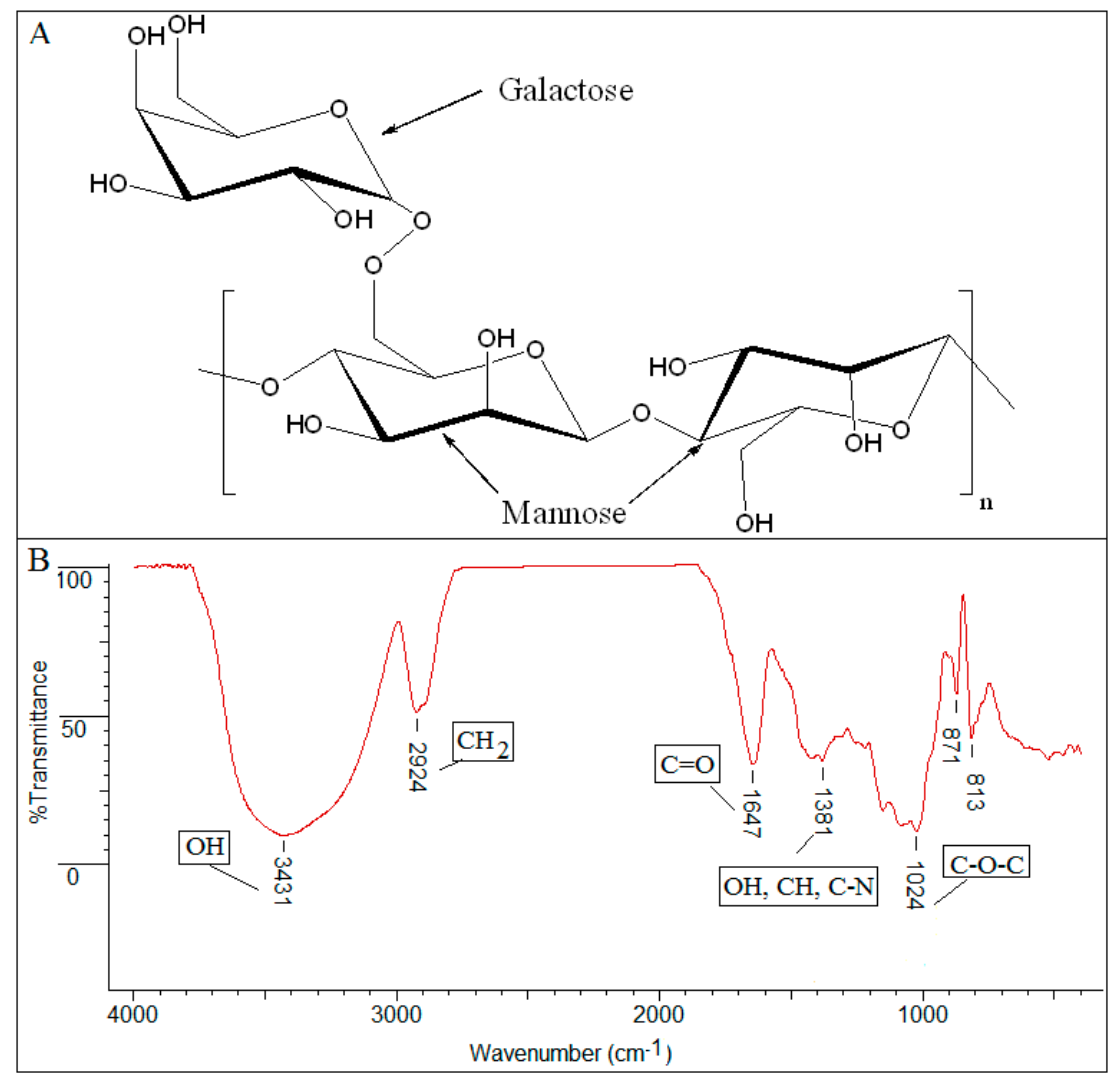
Figure 2. ( A ) Guar gum chemical formula; ( B ) FTIR-ATR spectrum of dried sample guar gum analysed using a Nexus FTIR Diamond instrument (Thermo Scientific) with a Smart Orbit diamond crystal ATR accessory in the range of 400–4000 cm − 1 .